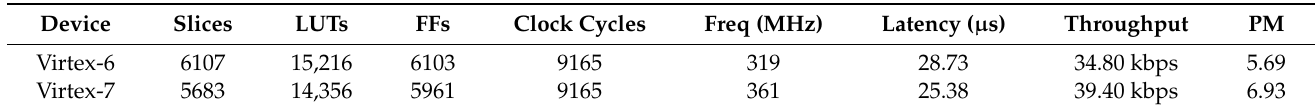
Table 2. Implementation results of our large-field size ECC processor over GF ( 2 571 ) on Xilinx FPGA